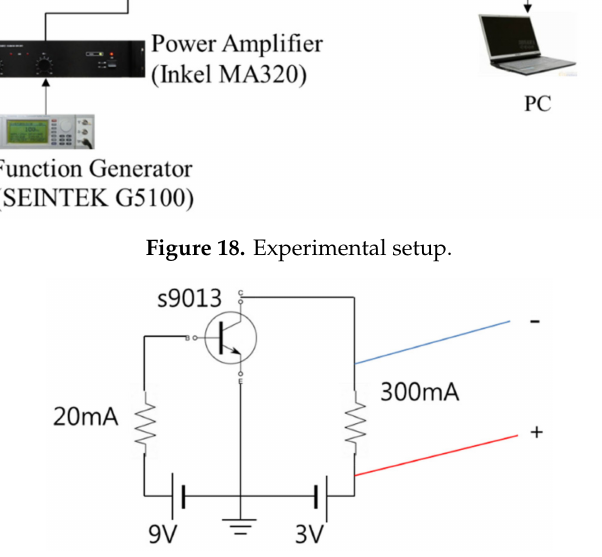
Figure 19. Circuit of current